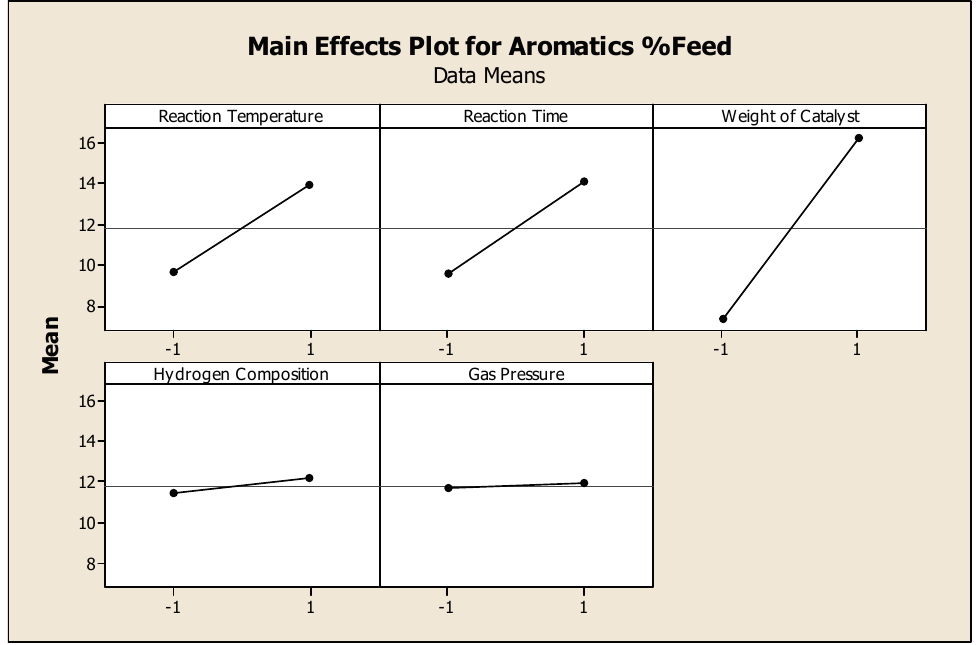
Figure 2. Main effect plot for recovered